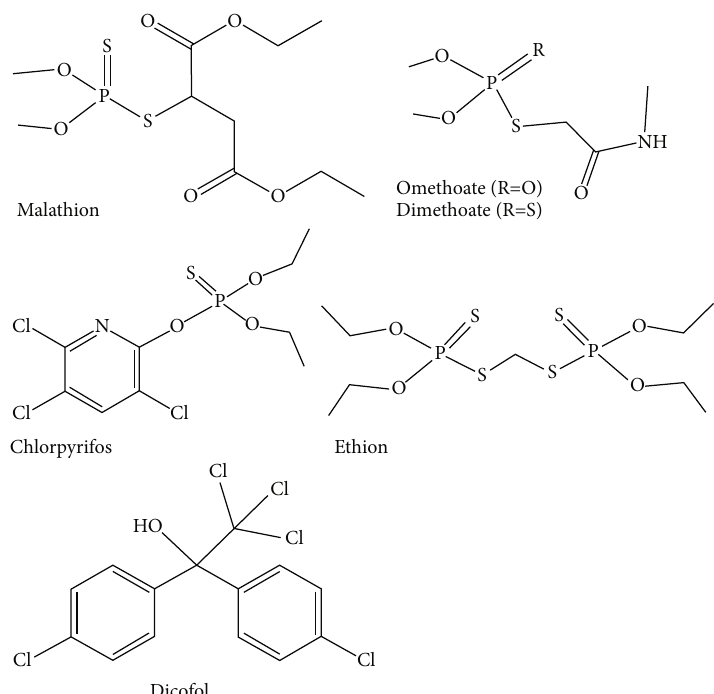
Figure 8: Pesticide active ingredients of the organophosphate and organochlorine groups reported by RASFF of the European Union in processed chilli pepper and